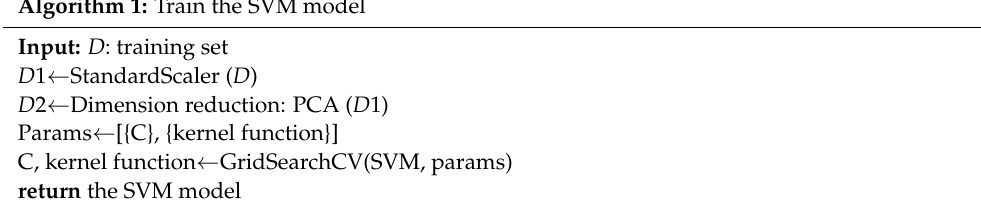
Algorithm 1: Train the SVM